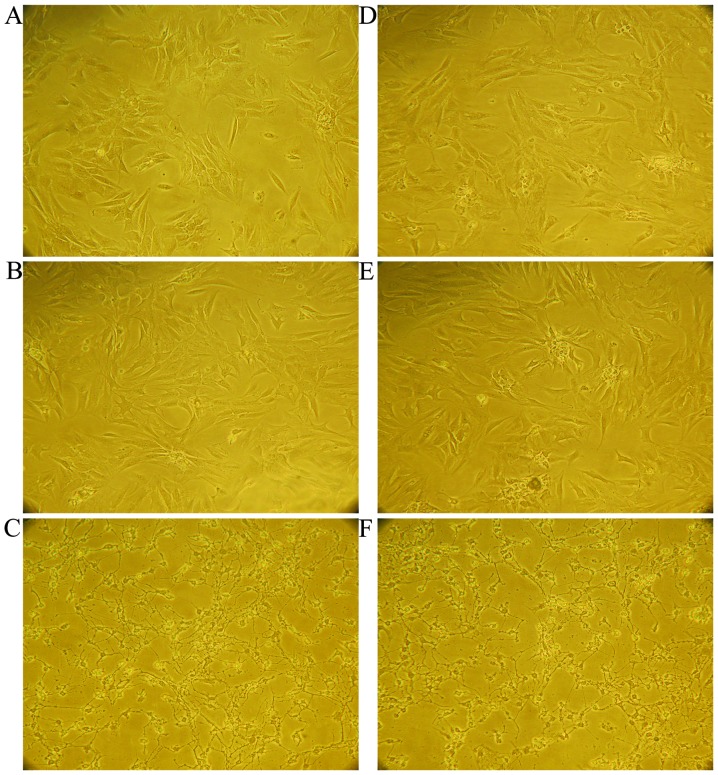
Morphology of nucleus pulposus (NP) cells derived from degenerative human disc from passage 2 and 3 (magnification, ×100). (A–C) NP cells from passage 2 following transfection for 3 days with.the blank control (equal amount of DMEM/F12 medium), negative control (empty LV) and positive control (LV with survivin), respectively. Following transfection with survivin, cytomorphosis, the reduction of the cytoplasm and cell shrinkage were evident. The cell volume changed significanlty, and pseudopodia became longer. (D–F) Using the cells described in (A–C, respectively), the cells were passaged for 1 more day. The morphology of the third-passage cells was similar to that of the second-passage cells.